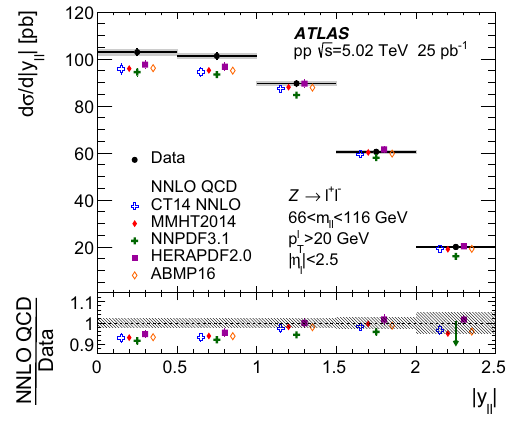
Fig. 11 Differential cross sections for a W + and b W − boson produc- tion as a function of absolute decay lepton pseudorapidity compared with theoretical predictions. Statistical and systematic errors are shown as corresponding bars and shaded bands on the data points. The lumi- nosityuncertaintyisnotincluded.Onlythedominantuncertainty(PDF)